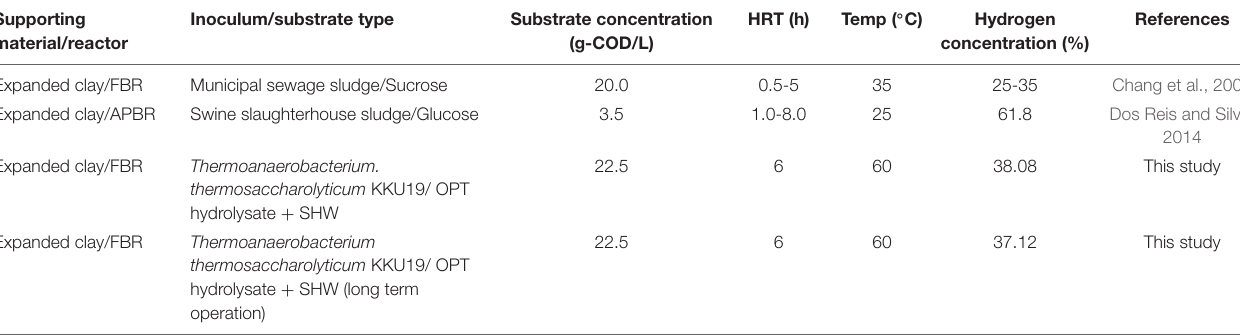
TABLE 3 | Comparison of hydrogen concentration of this study with the literature